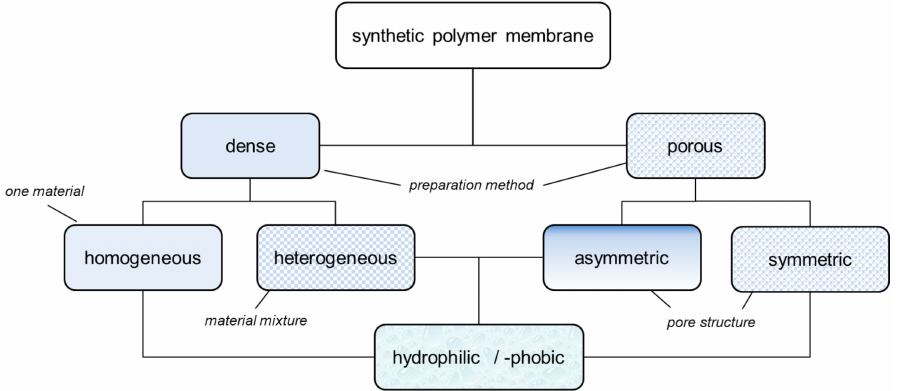
Figure 3. Classification of synthetic membranes according to their